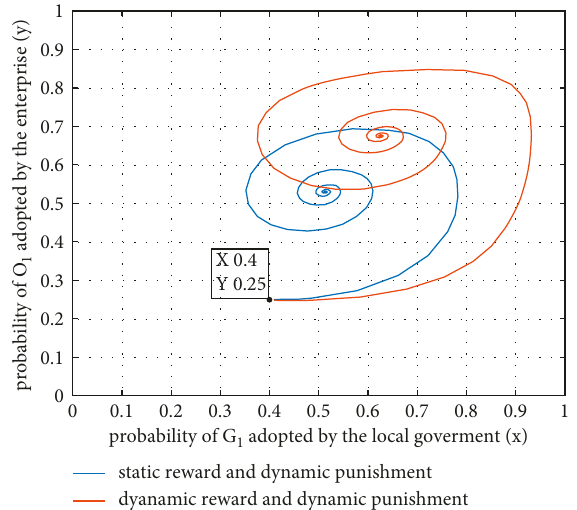
Figure 7: Comparison of the dynamic evolutionary paths of local government and enterprise for system 3 and system